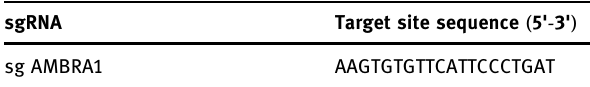
Table 1: Sequences of the shRNAs targeting AMBRA1 and CCND1